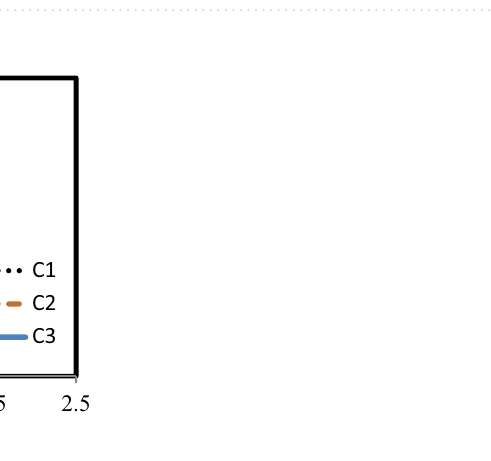
Figure 3. Molecular structure of C3 showing the atom numbering scheme with 50% probability of thermal ellipsoids.